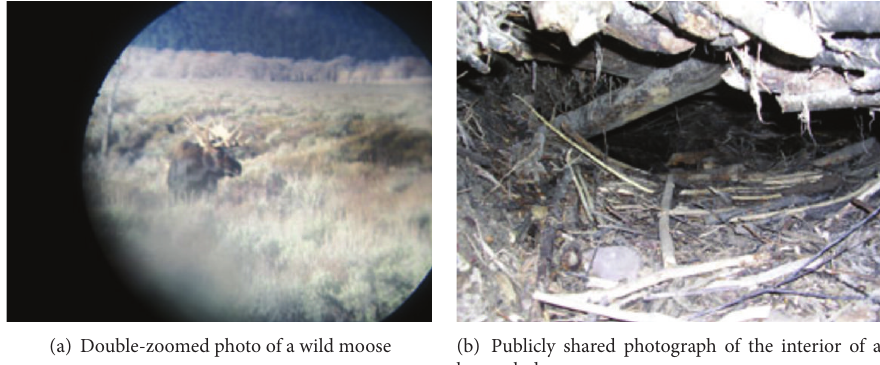
Figure 4: Photographs taken (a) using the magnification capabilities of both binoculars and a camera and (b) to publicly share the interior of an intact beaver